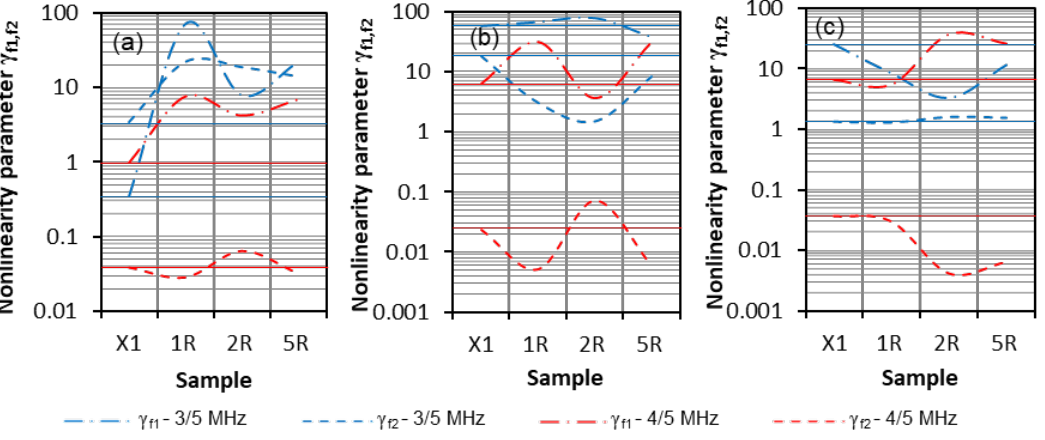
Figure 22. Comparison of 𝛾 𝑓1 and 𝛾 𝑓2 parameters: ( a ) α = 45°; ( b ) α = 60°; ( c ) α = 90°.